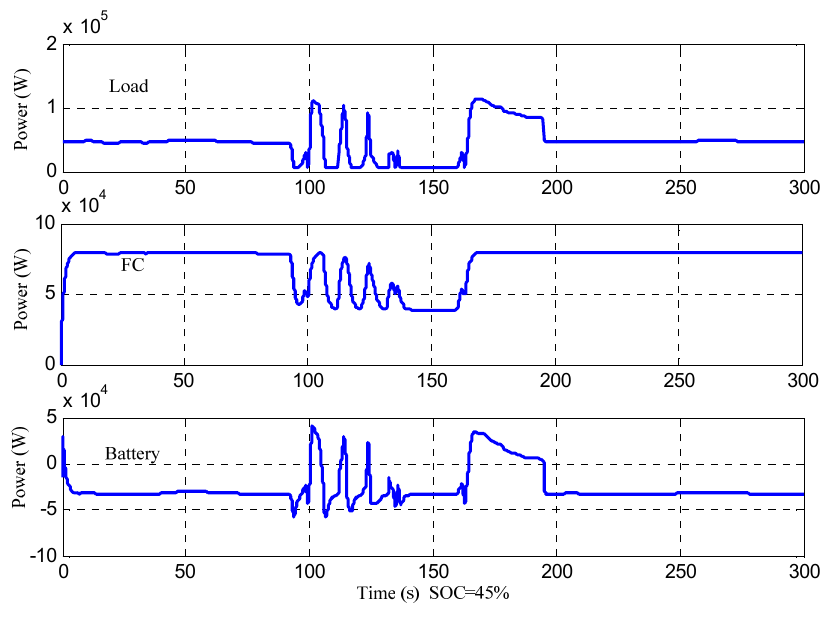
Figure 12. Battery characteristics for Case 1.